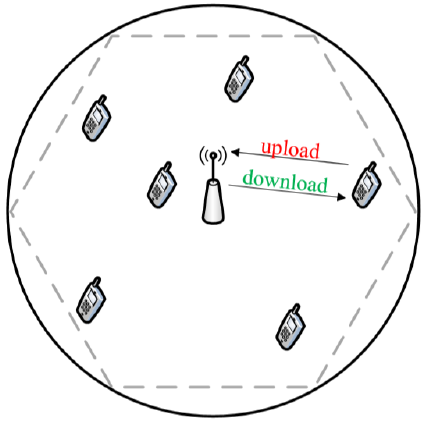
Figure 1. Scheme of System